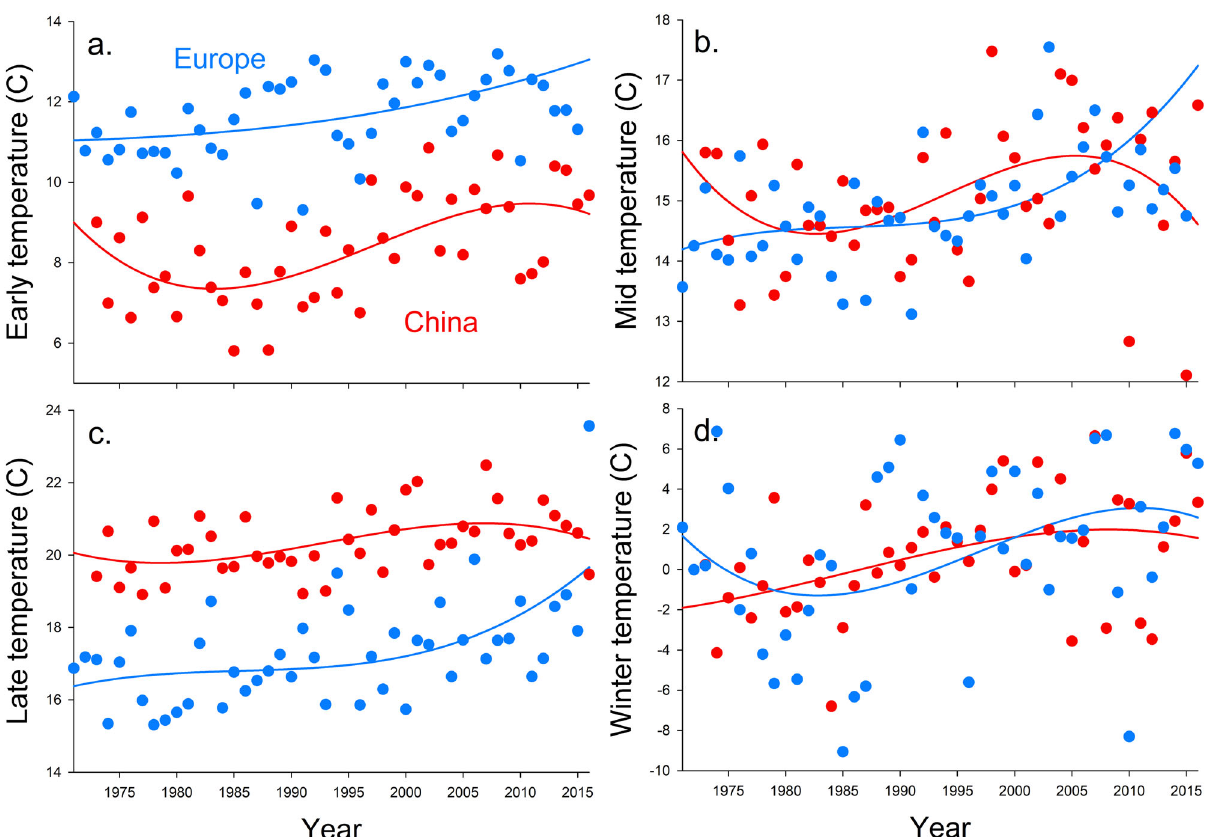
Fig. 4 Historical temperatures in China and Europe. Trends of temperatures in China and Europe in early ( a ), mid ( b ), and late ( c ) wheat growing seasons and winter ( d ) from 1971 to 2015. Red lines represent the average for provinces that provided aphid data for China and blue lines represent the average for countries that provided aphid data for Europe.